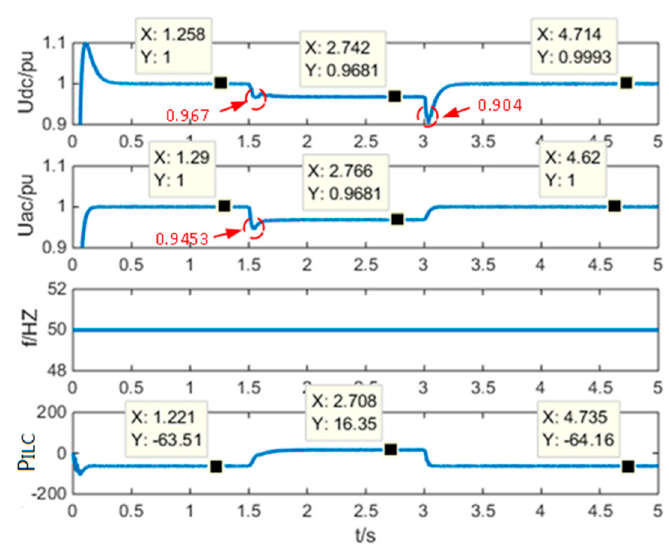
Figure 17. DC voltage, AC voltage, frequency, and ILC transmission power (DC load = 112.5 kW; AC load = 75 kW).